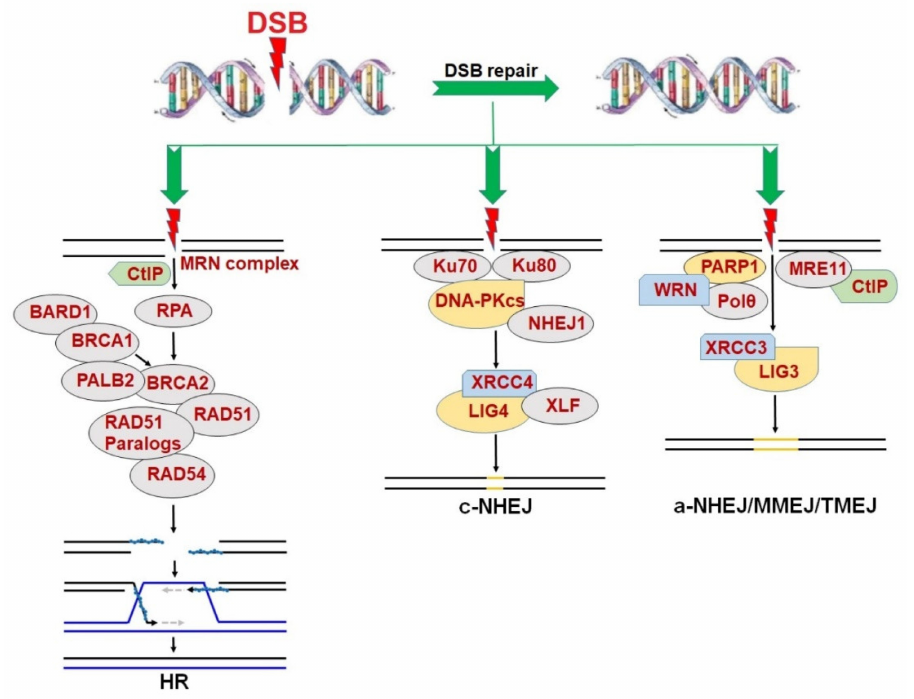
Figure 1. DNA double strand break (DSB) repair pathways including homologous recombination (HR), canonical non-homologous end joining (c-NHEJ) and alternative non-homologous end joining (a-NHEJ)/microhomology-mediated end joining (MMEJ)/DNA polymerase theta (Pol θ )-mediated end joining